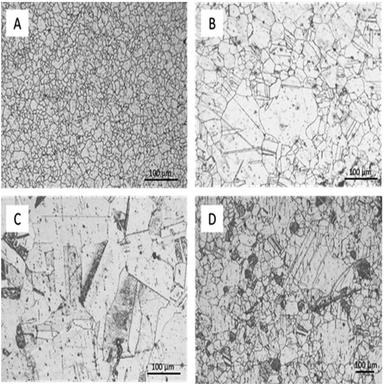
Indicative optical micrographs of four selected samples: A, As received (c3a10); B, 1005°C recrystallisation (longitudinal, a1a10); C, 1005°C recrystallisation (transversal, a1a10); and D, cold work to 1% followed by partial recrystallisation at 880°C (Longitudinal, 4f880).